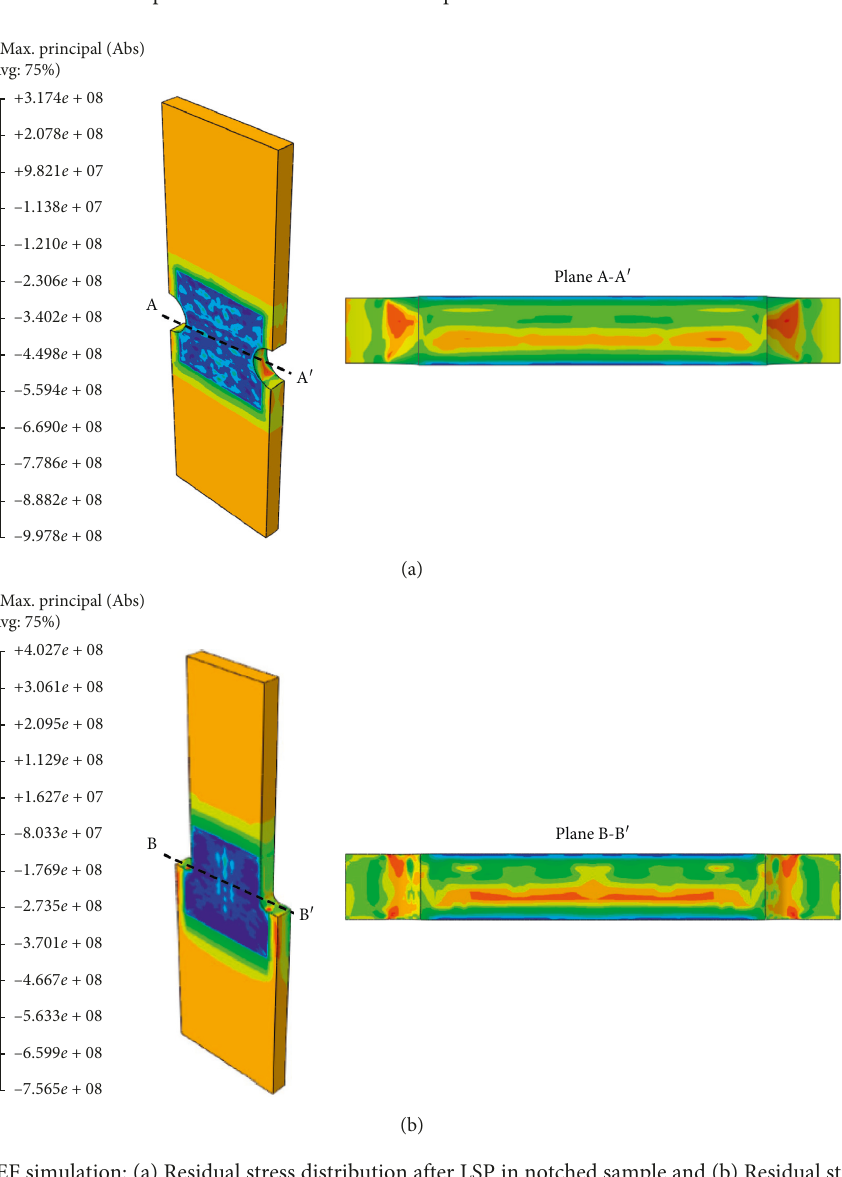
Figure 7: Experimental and simulation comparison of residual stress distribution.